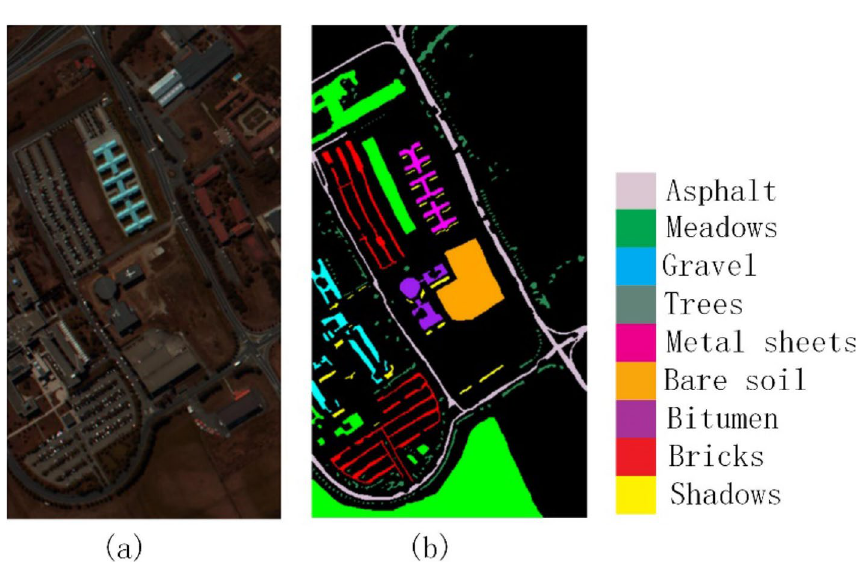
Figure 3. Pavia University data set. ( a ) False-color map; ( b ) Ground-truth